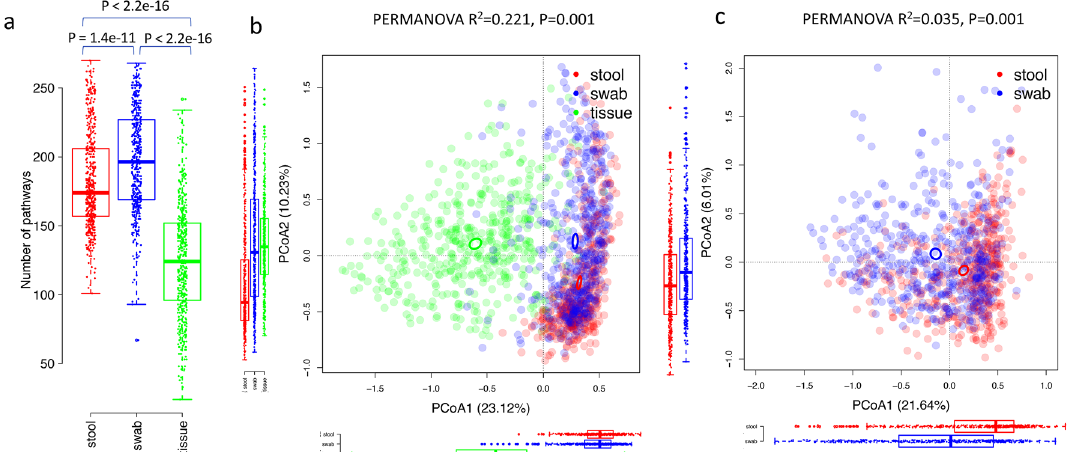
Figure 3. The number of pathways and PCoA ordinations of functional pathways of microbial metagenomes. Color indicates the sample types. (a) The number of pathways across samples. Differences between sample types were tested with Wilcoxon Rank Sum test. (b) Mucosal tissue samples formed a distinct cluster from stool and swab samples. Ellipses indicate 95% confidence limits of the centroids (added with function ‘ordiellipse’ in R package ‘vegan’). (c) Visualization of only stool and swab samples. The boxplots below and on the left of the PCoA plots showed the distribution of coordinates of stool, swab and mucosal tissue samples on PCoA1 and PCoA2. The boxplots showed the median, 25th and 75th